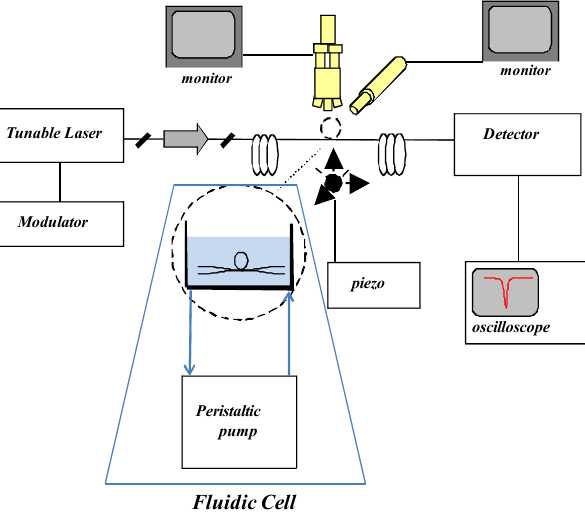
Figure 1. A schematic diagram of the experimental arrangement.